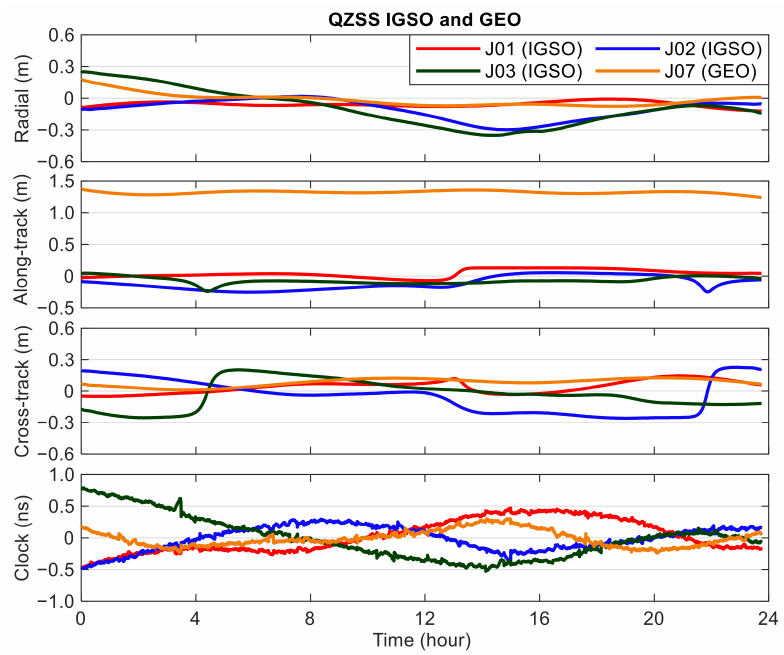
Figure 8. Epoch-wise orbit and clock differences for QZSS GEO and IGSO satellites between GFZ and WHU precise products on DOY 122 of